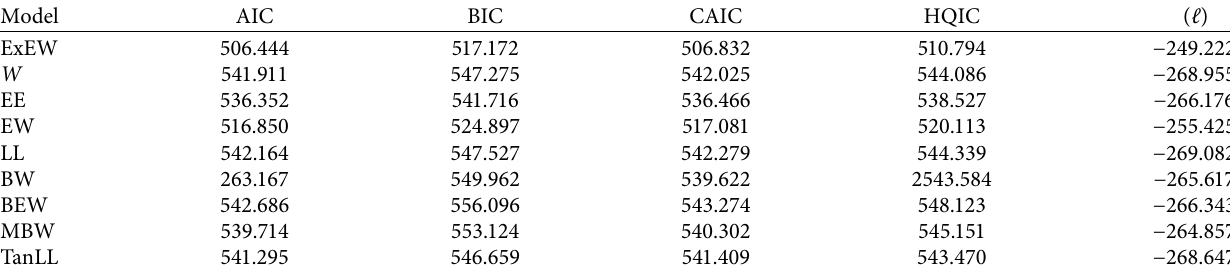
Table 13: The analytical performance measures for comparing distributions for COVID-19 fatality rate data.